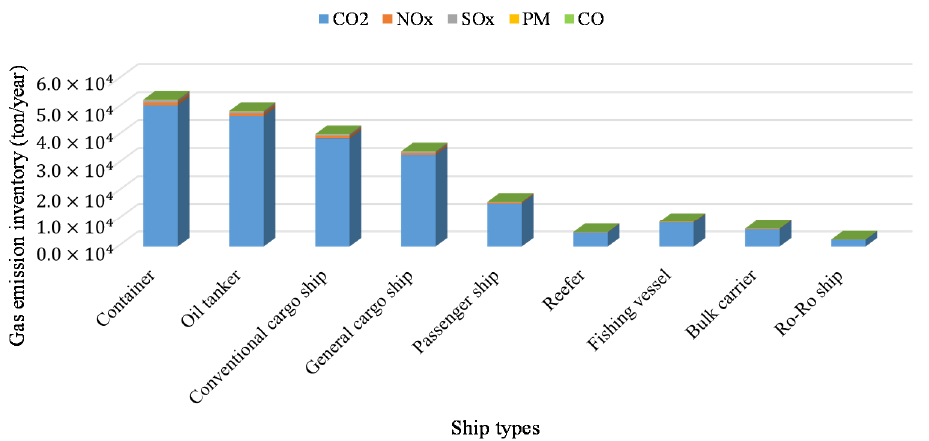
Figure 6. Proportion of the gas emission by ship type in BP in